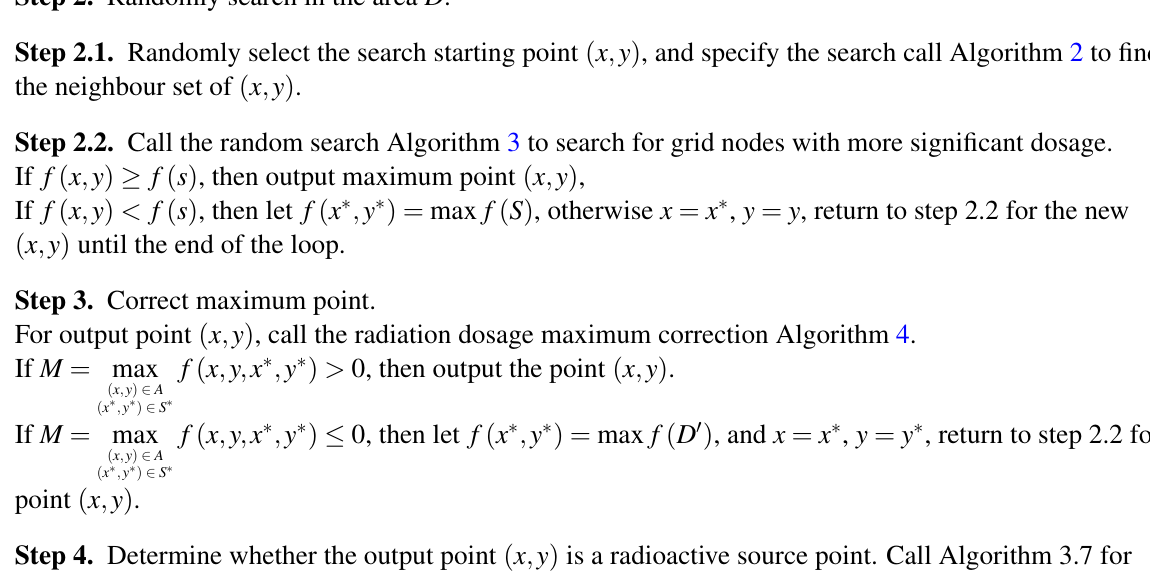
Algorithm 8: Random Search Optimisation